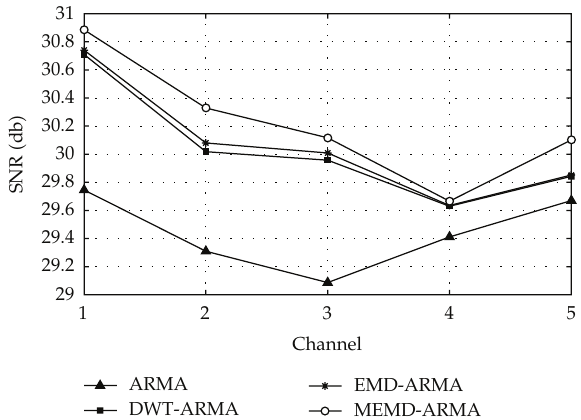
Figure 14: Comparison (cid:2) in SNR (cid:3) of proposed MEMD-ARMA, model with ARMA, DWT-ARMA and EMD- ARMA for di ff erent channels of financial data.